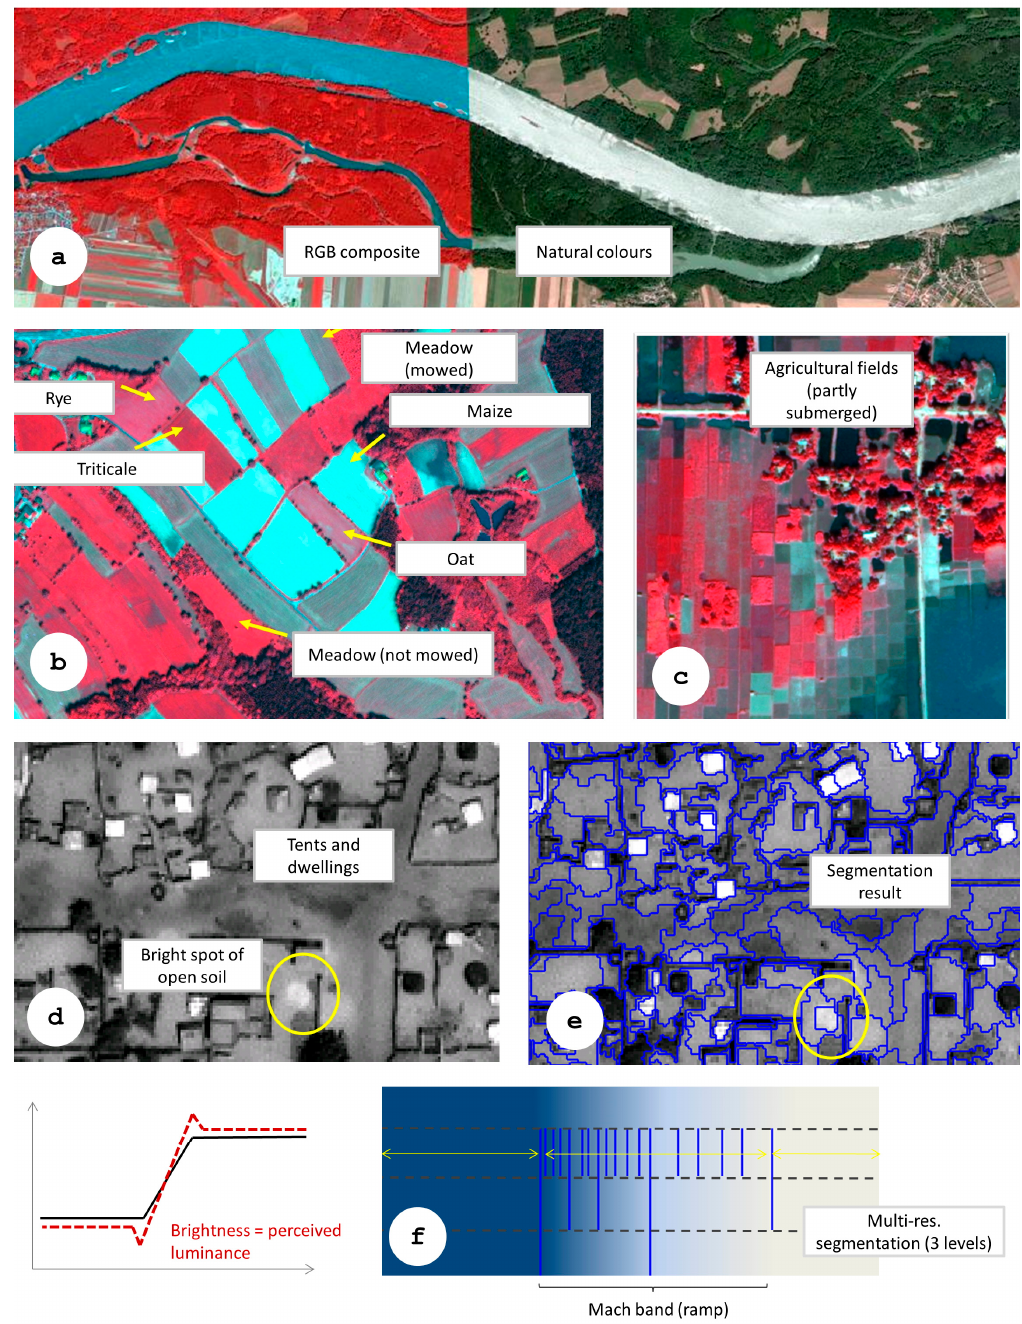
Figure 1. Capacities of human vision: ( a ) WorldView-2 scene of the Danube riparian flood plain near Vienna, Austria showing a continuation of the scene content (from left to right), even if the colour scheme changes from NIR (‘false colour’) to RGB (‘true-colour’); ( b ) Quickbird image of a rural area in Austria; and ( c ) Assam, India: agricultural scenes, recognized by field arrangements, while the primary cue is shape and regularity, colour in both cases provides significant additional cues for interpretation. ( d ) Geoeye-1 panchromatic imagery of a refugee camp in Sudan: brightness helps distinguish tents as small, compact features, while the decisive visual cue is the shadow cast by tents, and when missing (yellow circle), the hypothesis of a white spot representing a tent no longer holds, even if ( e ) segmented in the same way as others; ( f ) psychophysical phenomenon of the Mach bands visual illusion—where a luminance (radiance, intensity) ramp meets a plateau, there are spikes of brightness, although there is no discontinuity in the luminance profile; consequently human vision detects two luminance boundaries, one at the beginning and one at the end of the